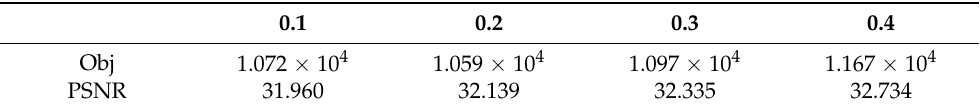
Table 2. Objective function values and PSNR values of IPGM models with different inertia parameters under the constraint of nonconvex optimization.